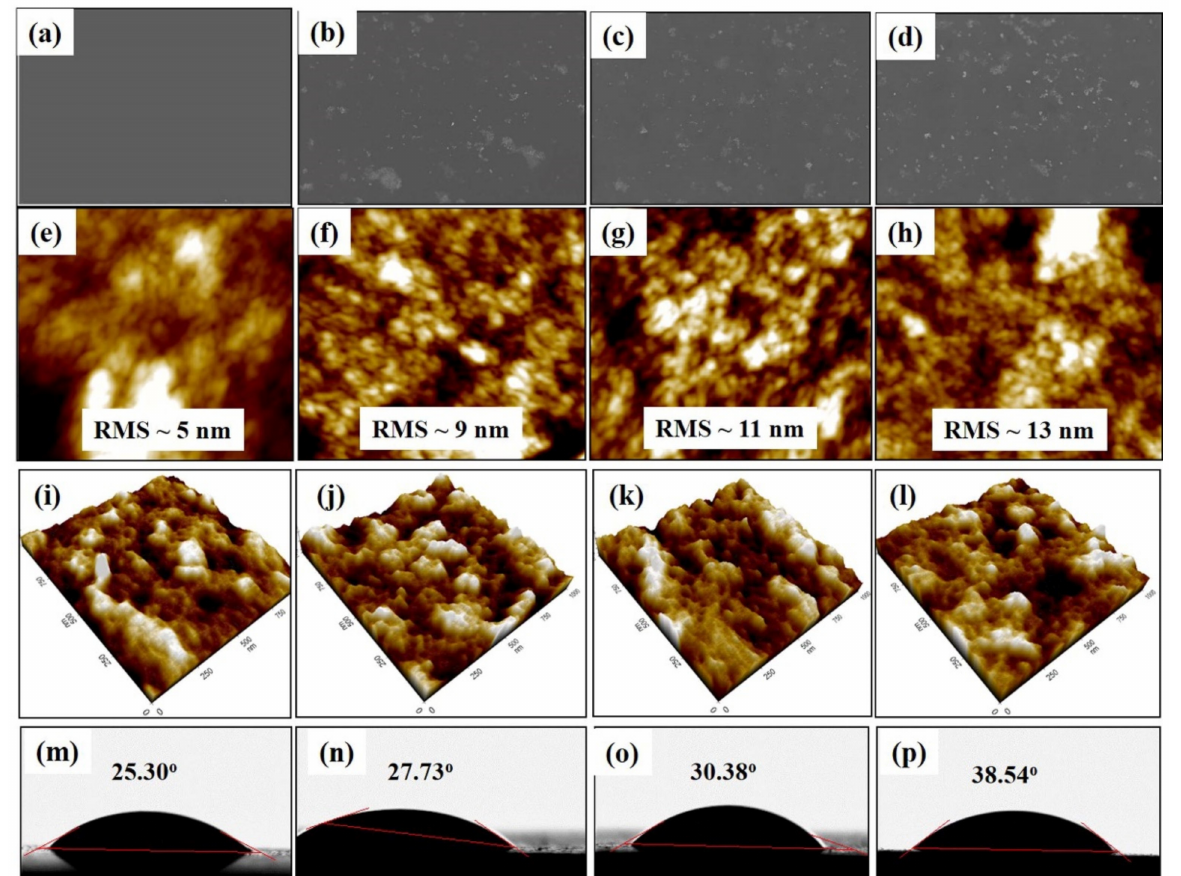
Figure 3. ( a – d ) Surface morphology of PEDOT:PSS layer without and with Au nanorods incorporation measured using SEM; ( e – l ) Surface roughness morphology (RMS) of PEDOT:PSS layer without and with Au nanorods incorporated, measured using AFM; ( m – p ) Video contact angle images of PEDOT:PSS layer without and with Au